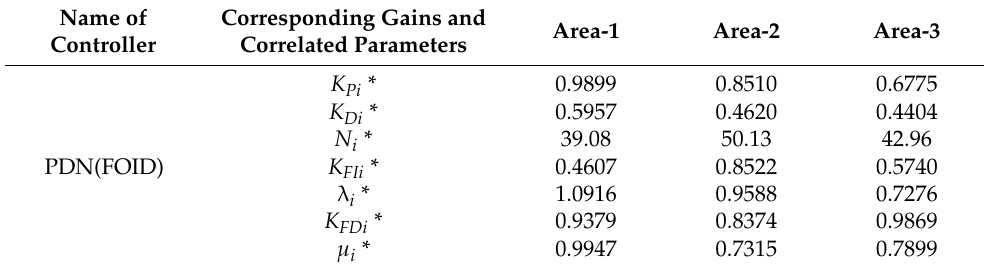
Table 7. Best values of gains and related parameters of PDN(FOID) controllers for scheme-4 (thermal– bio-diesel–GPP-Ss (GT) system including both WavePPt,